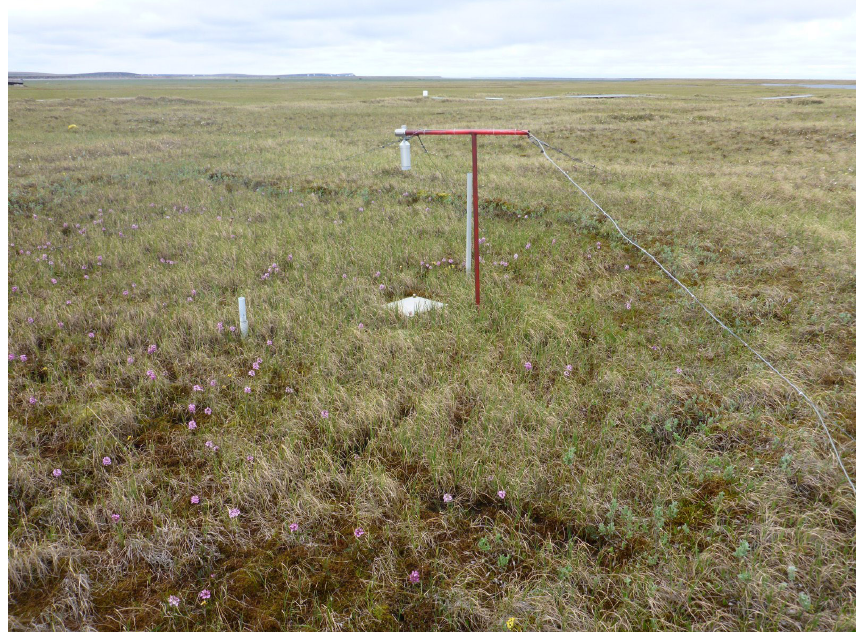
Figure B4. Campbell Scientific SR50 snow depth sensor, installed on 24 August 2002. An aluminum plate was installed on the ground surface beneath the sensor beam on 17 July